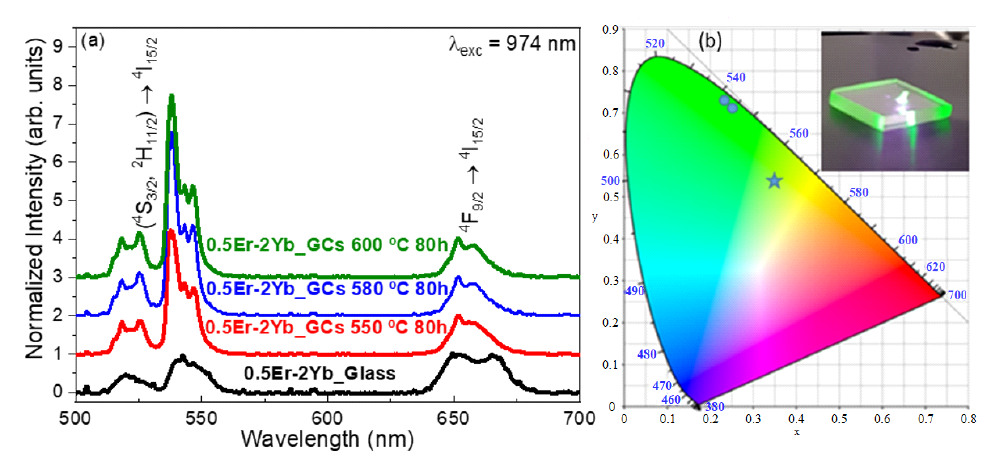
Figure 9. ( a ) UC-emission spectra of 0.5Er 3 + –2Yb 3 + -codoped 70Si7Gd glass and GCs treated at di ff erent temperatures for 80 h under excitation at 974 nm; ( b ) CIE-standard chromaticity diagram showing up-conversion emissions of 0.5Er 3 + –2Yb 3 + -codoped 70Si7Gd glass and GCs treated at di ff erent temperatures for 80 h under excitation at 974 nm. Inset in ( b ) picture of 0.5Er 3 + –2Yb 3 + -codoped 70Si7Gd GCs under IR excitation at 974 nm showing an e ffi cient visible green UC